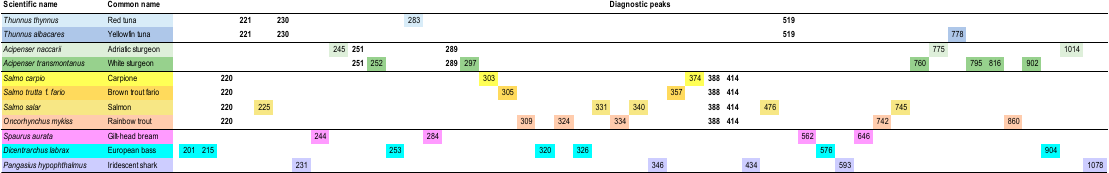
Figure 4. Numerical TBP profiles of representative fish species. The graph reports with colored background those TBP amplifiable fragments that specifically associate to the fish species enlisted on the left. Amplicons, retrieved from the complete TBP-based genomic profile, are denoted by their sizes, expressed in base pairs. Numbers with no background are shared within a member of a higher taxonomic ranks.